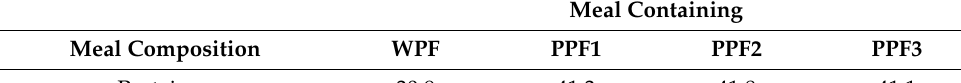
Table 1. Cont. Meal Containing Meal Composition WPF PPF1 PPF2 PPF3 Protein, g 30.9 41.3 41.8 41.1 Salt + ash, g 0.8 1.4 1.1 Energy, kcal 454.2 495.7 497.8